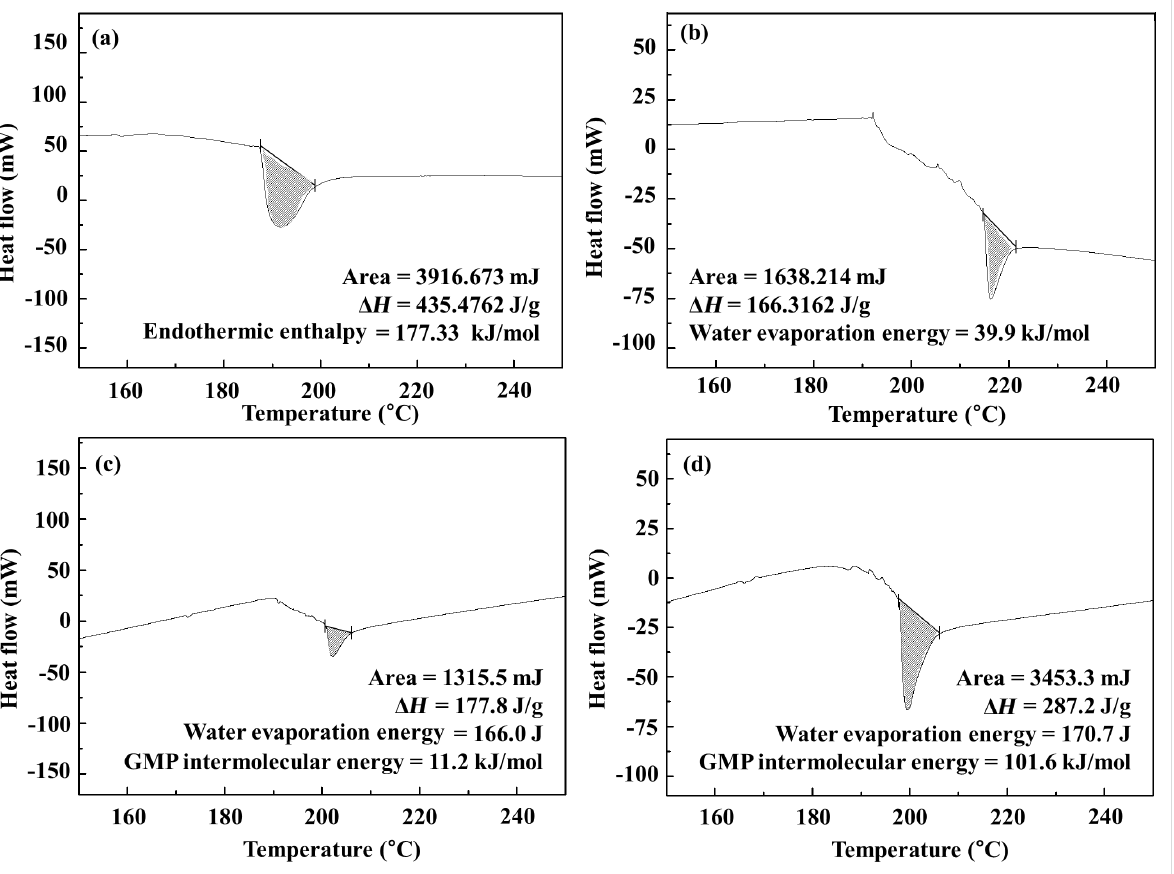
Figure 5: Differential scanning calorimetry (DSC) diagrams of (a) GMP powder, (b) pristine MgAl-NO 3 -LDH, (c) GL-S and (d) GL-R.